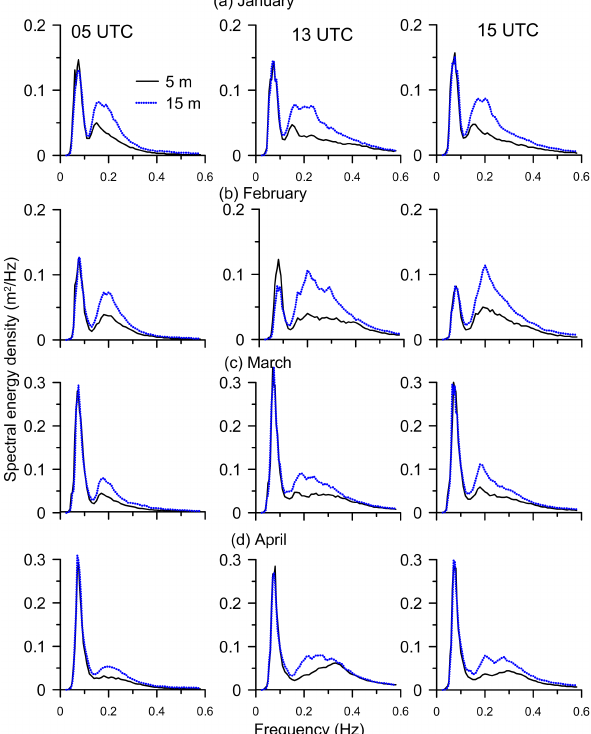
Figure 13. Monthly average wave spectrum at 05:00, 13:00 and 15:00UTC during January–April at 5 and 15m water